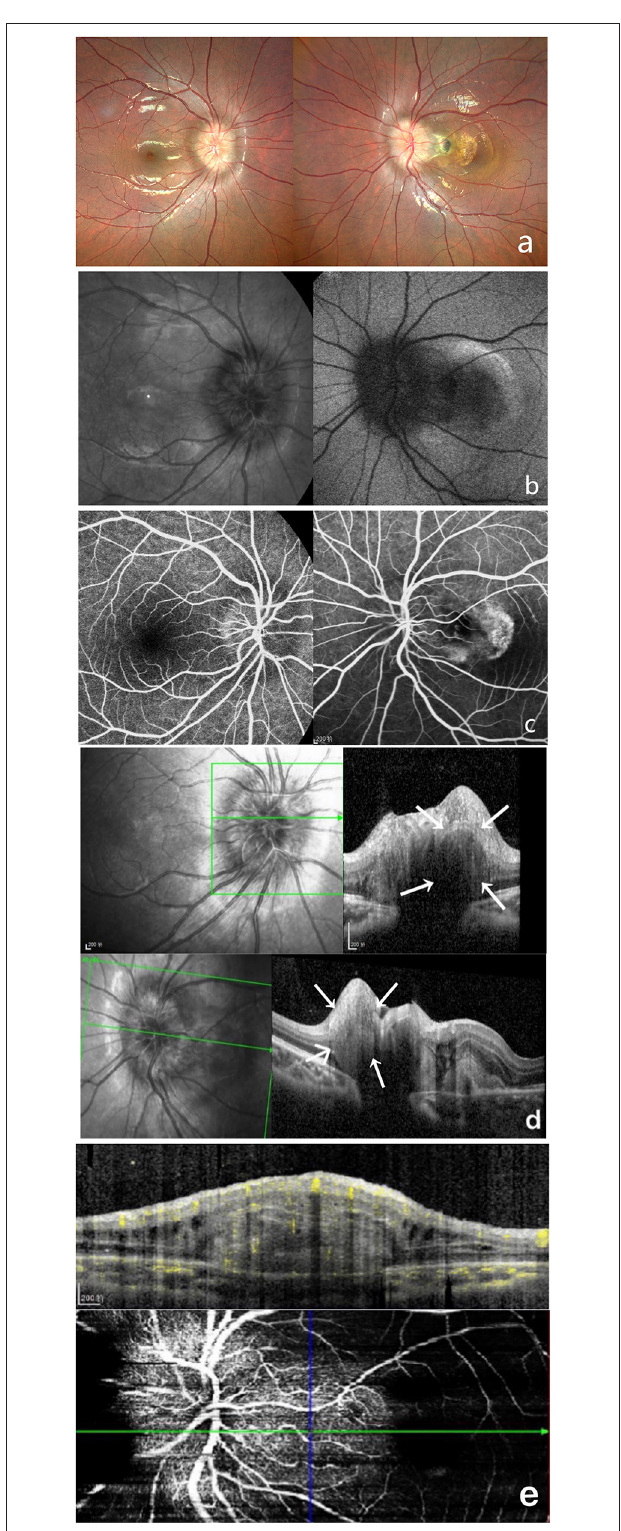
FIGURE 2 | Multi-modal image data of case 2. (a) Color fundus photography showed unclear optic disc boundaries, as well as are fibrosis and serous detachment of the retina in macular area. (b) This case did not show